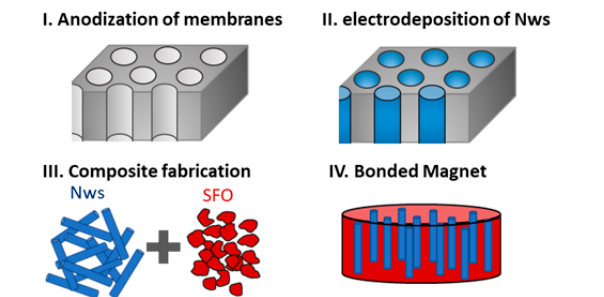
Figure 5. Schematic of the steps followed to fabricate the composite bonded magnet